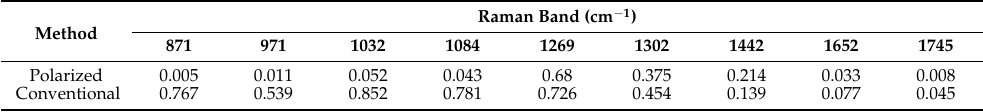
Table 5. Statistical differences ( p -values) between lipid band intensities of normal and cancerous breast tissues collected with conventional and parallel polarized spectra, respectively.